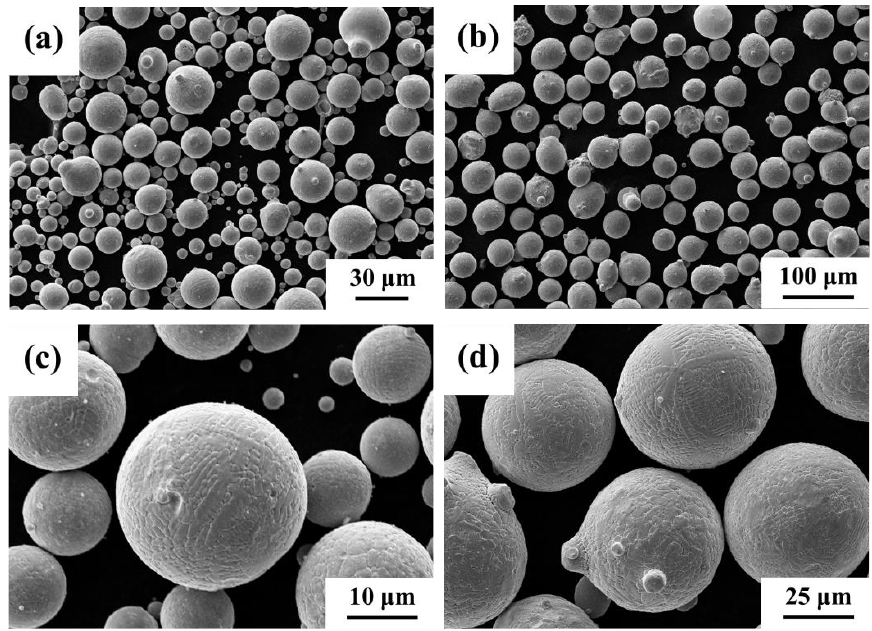
Figure 1. SEM secondary electron images of CoCrFeNiMn high-entropy alloy powders. ( a , c ) CS powders; ( b , d ) HVOF powders.